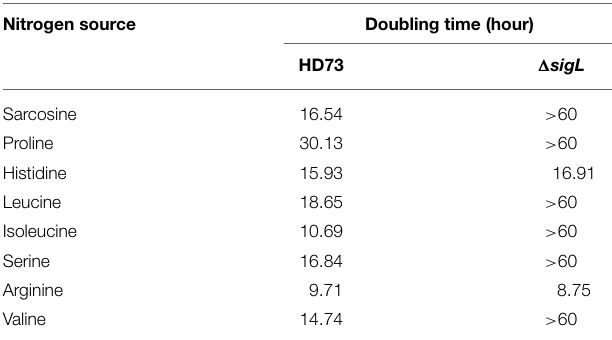
TABLE 1 | Doubling time of HD73 wild type and 1 sigL mutant strains grown in minimal medium containing various nitrogen sources. Nitrogen